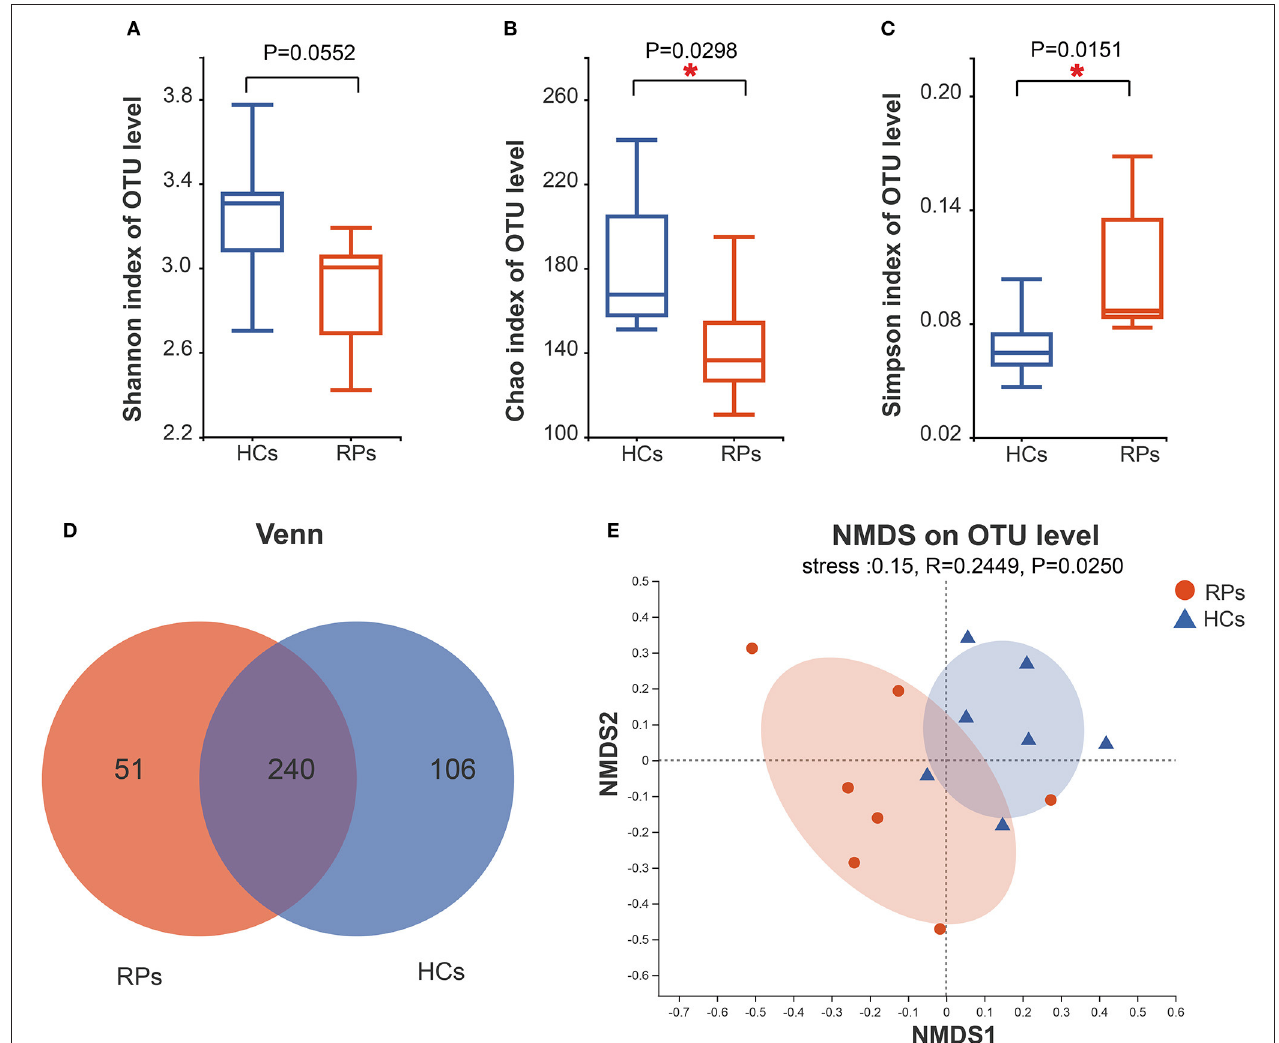
FIGURE 2 | Differences in the diversity and richness of fecal microbiota between recovered COVID-19 patients and healthy controls. The Shannon (A) , Chao (B) , and Simpson index (C) were calculated at a 3% distance. (D) A Venn diagram indicates the overlapping and unique OTUs among the groups. (E) Non-metric multidimensional analysis (NMDS) was conducted at the OTU level to show the different distribution of recovered patients and controls.